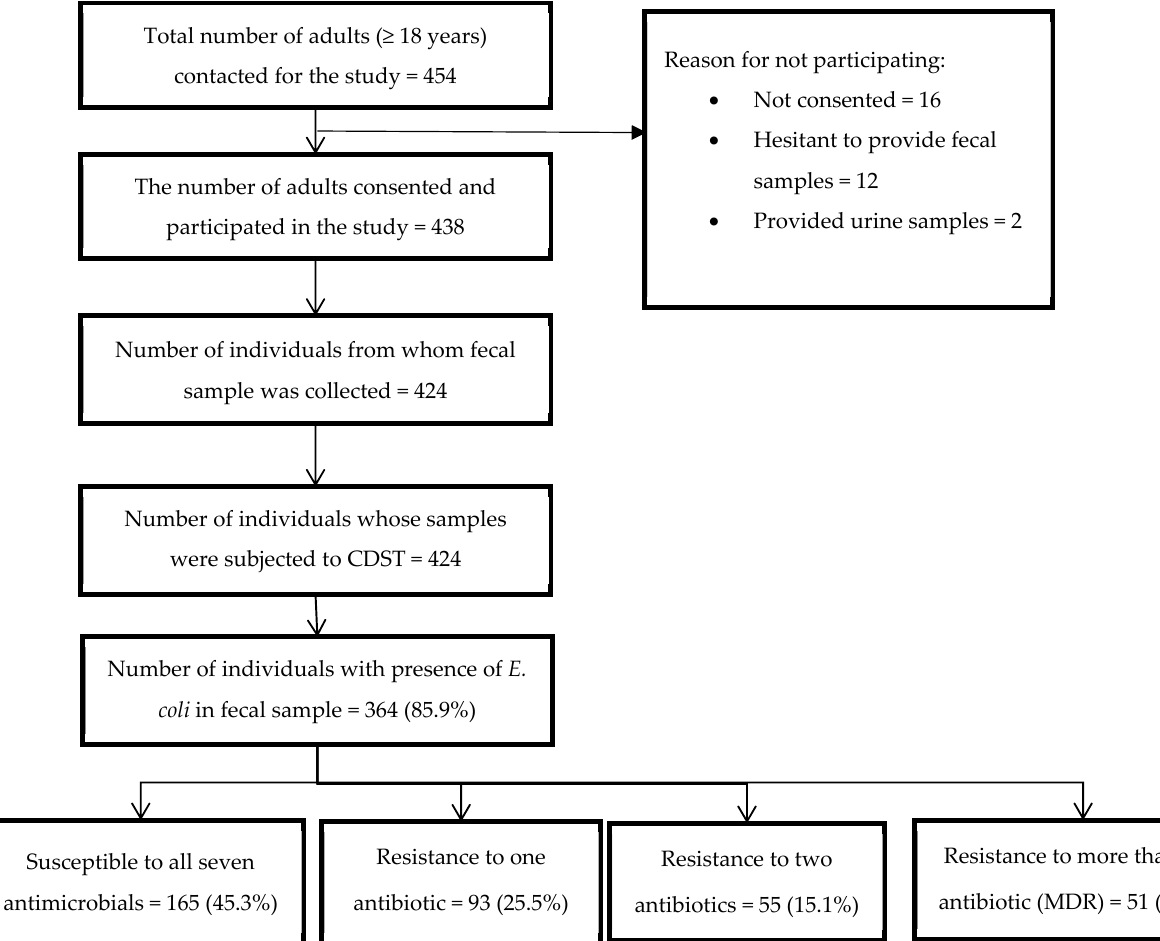
Figure 1. Flow chart depicting the patterns of resistance in E. coli in fecal samples from healthy humans and resistance to antimicrobials among adults in Dhulikhel municipality in Nepal from